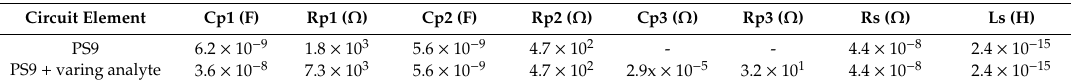
Table A14. Modeled impedance parameters Cp1, Rp1, Cp2, Rp2, Cp3, Rp3, Rs, and Ls of biochip PS9, with DI water and S. cerevisiae . Table A15. Modeled impedance parameters Cp1, Rp1, Cp2, Rp2, Cp3, Rp3, Rs, and Ls of biochip PS9, with 10% glucose as medium and S. cerevisiae.